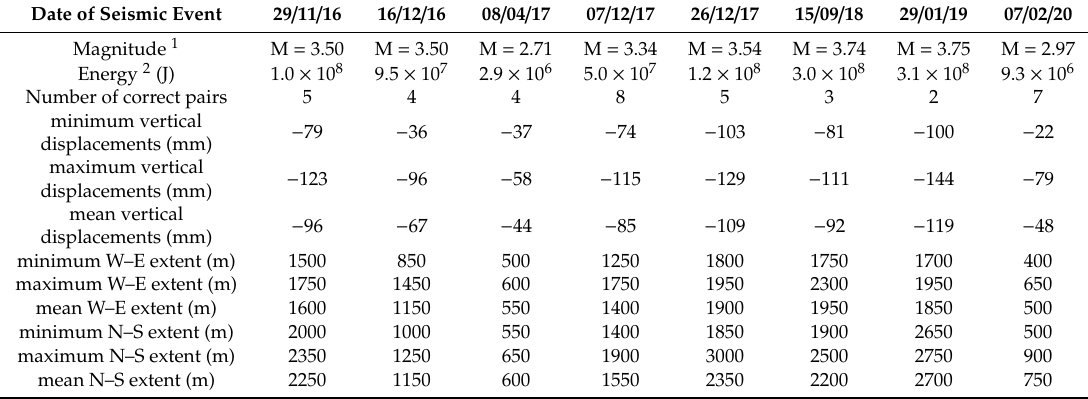
Table 3. Descriptive statistics for deformations resulting from the eight induced shocks including: magnitude, energy, vertical displacements, North-South (N–S) and West-East extents (W–E).